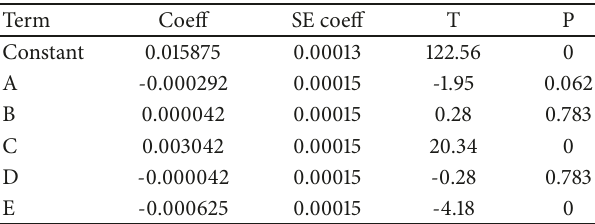
Table 9: Regression-coefficient evaluation for the sink marks.